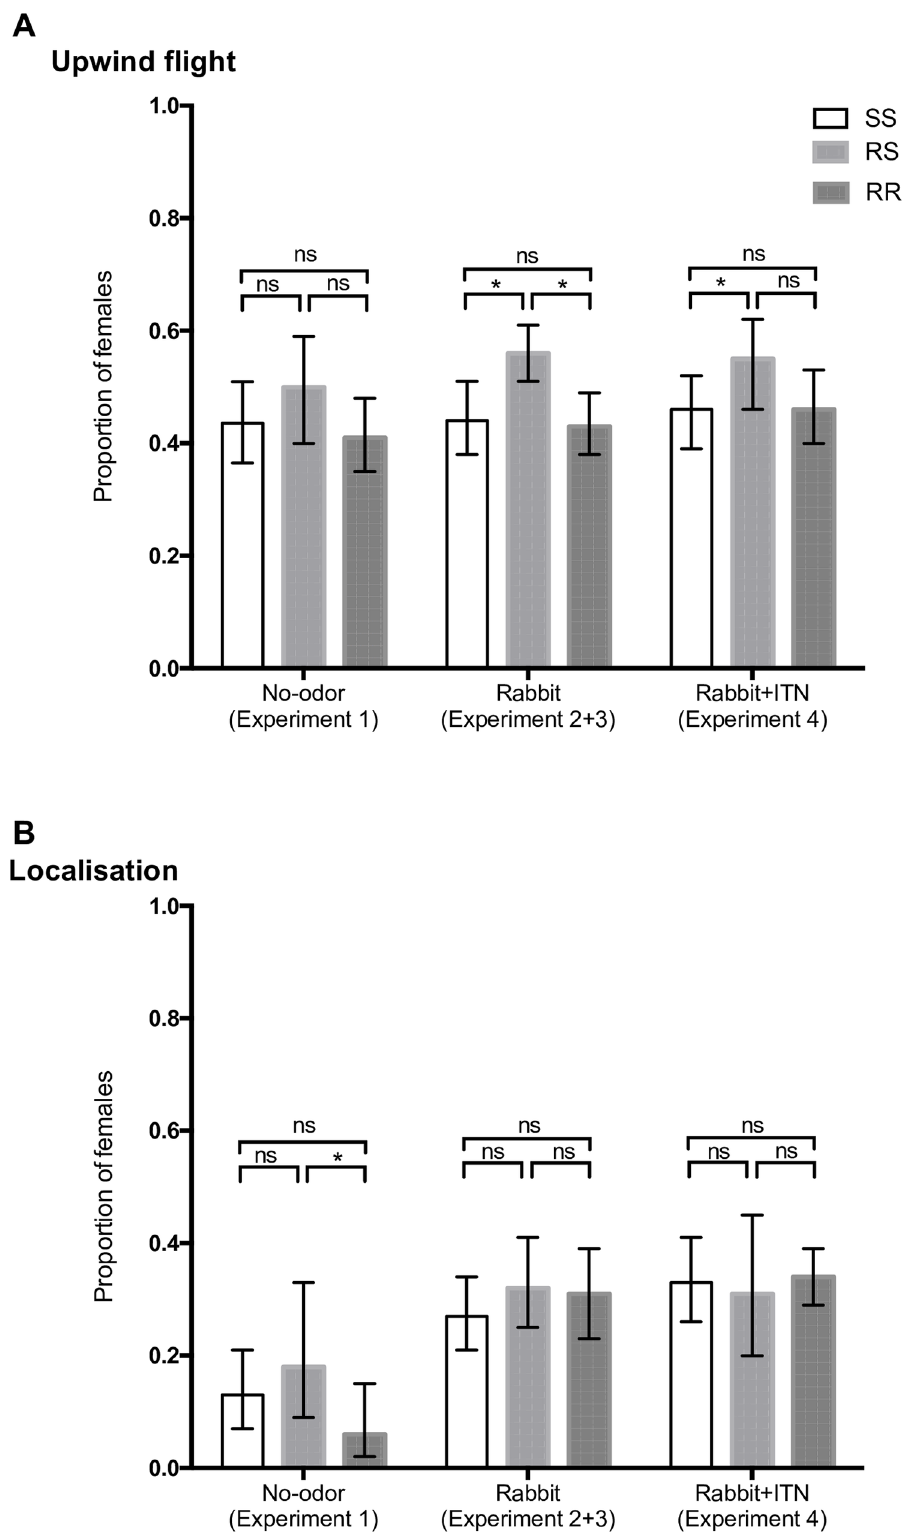
Fig 2. Upwind flight and localization indicators for the three genotypes in relation to treatment (Mean ± 95%Confidence Interval). *** p < 0.001, ** p (cid:20) 0.01, * p (cid:20) 0.05,ns = not significant.